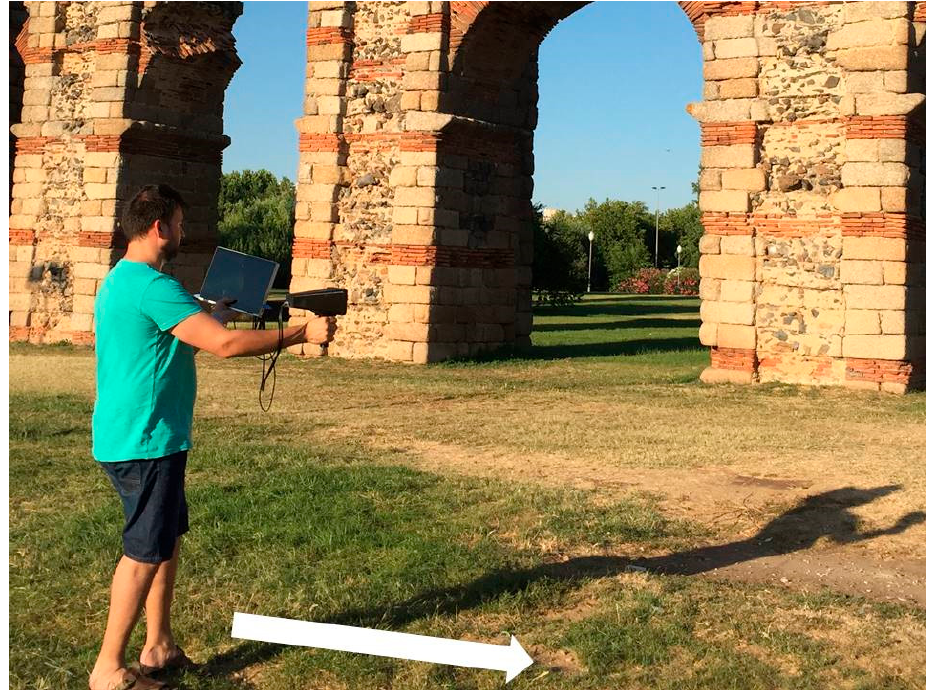
Figure 2. In-field data capture. The white arrow indicates the user direction movement, parallel to the monument façade, followed during this